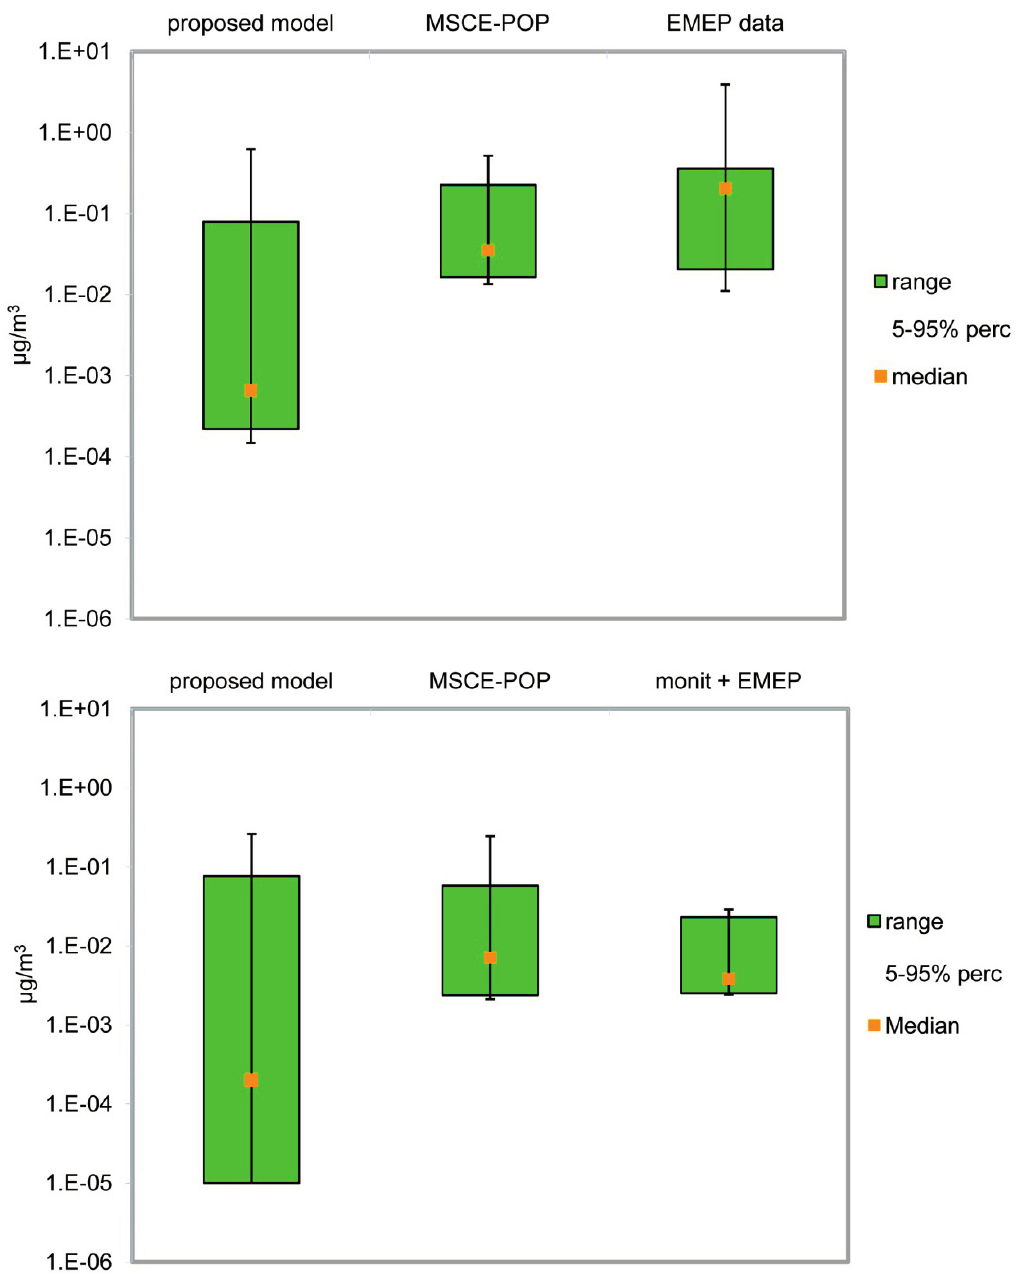
Figure 3. Comparison between predicted and monitored 5%–95% ranges of concentrations for 1995 ( above ) and 2005 ( below ). Monitored concentrations are obtained from